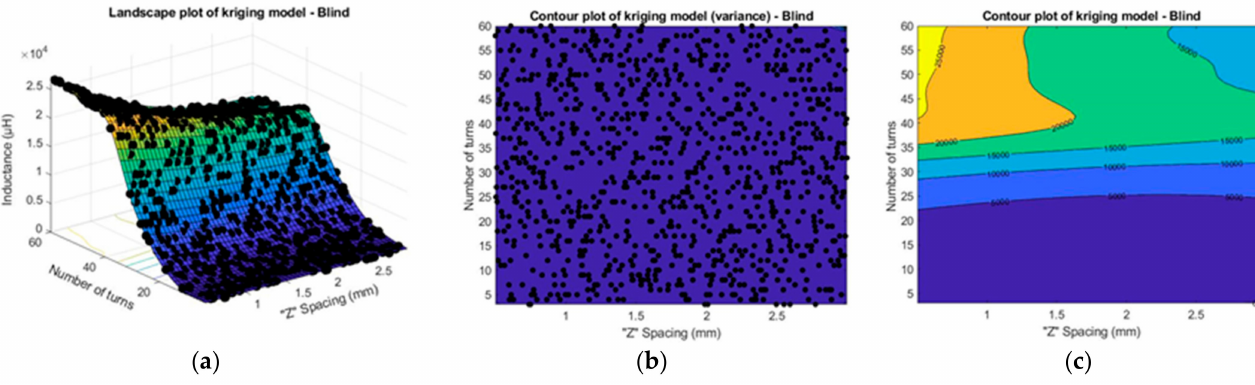
Figure 9. ( a ) The Blind Kriging response surface, ( b ) the variance plot and, ( c ) the contour plot of the